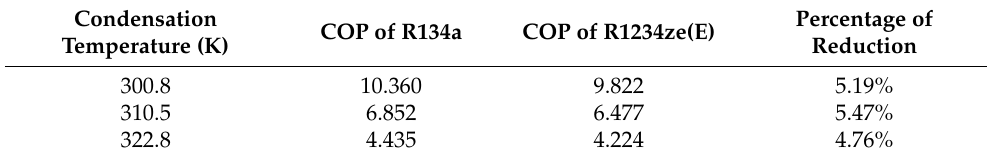
Figure 10. Diagram of the change of cooling capacity with condensation temperatures. Table 5. COP comparison of R1234ze(E) unit and R134a unit. Table 5. COP comparison of R1234ze(E) unit and R134a unit.